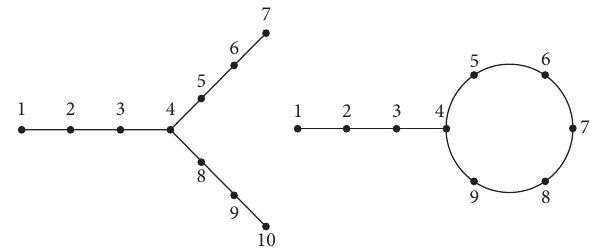
Figure 6: The two lines with the same line length but different number of